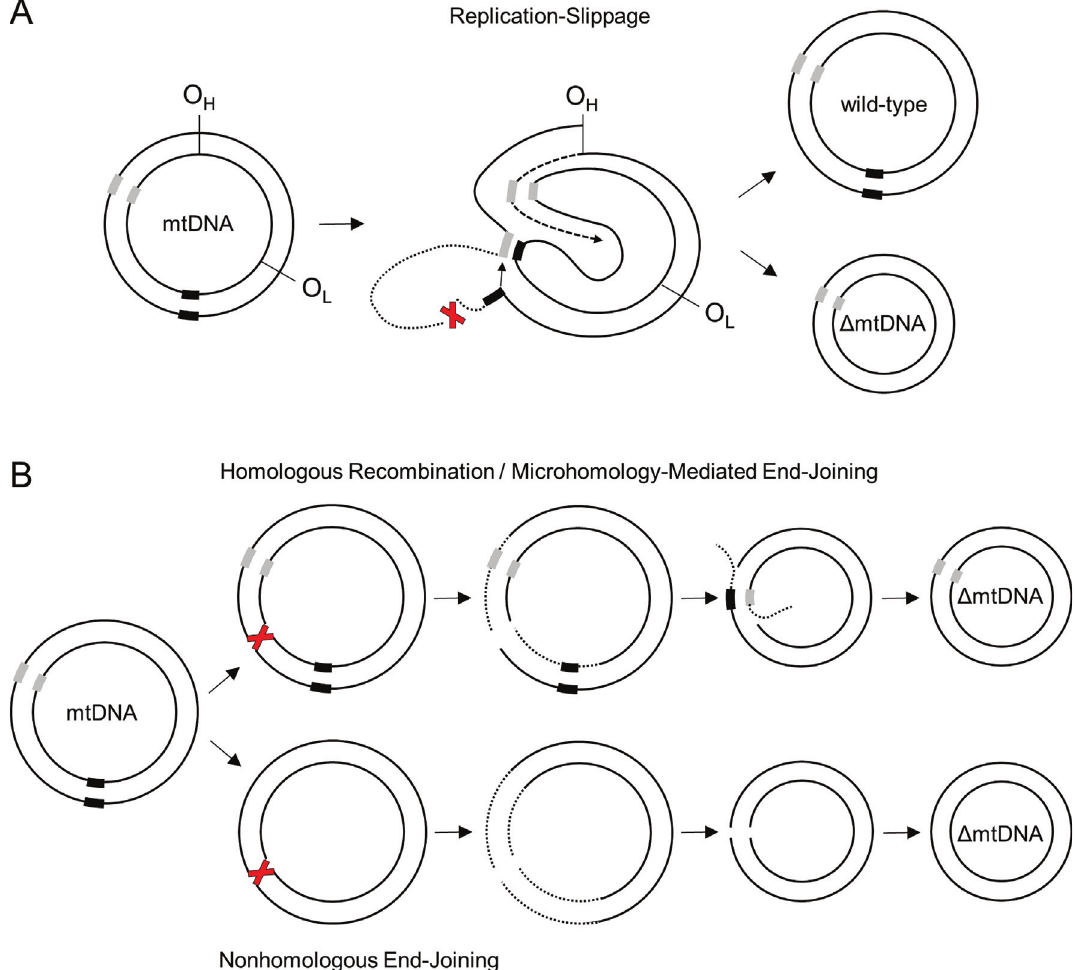
Figure 3 - Schematic representation of the debated mechanisms of mitochondrial DNA deletion formation. (A) In the replication-slippage (i.e. slipped mispairing) mechanism, a break of the displaced heavy DNA strand (indicated with a red X), generated during an asynchronous replication process, en- ablespairingofthe3’flankingregionofthatheavy-strand(greybox)withthe5’flankingregionofthelight-strand(blackbox),aheadoftheleadingDNA synthesis(dashedarrow).TheresultingunpairedDNAflap(dottedline)isthendegradedandligated(solidarrow)withtheremainderoftheheavy-strand. Replication initiated from O L would yield a daughter mtDNA molecule carrying the deletion of a segment ahead of the 3’ flanking region. The scheme representsthemodelproposedbyShoffner etal. (1989),anditwasmodifiedtoincorporatethelocationoftheheavy-strandbreaksaccordingtotheresults reported in Phillips et al. (2017). The position of the flanking regions corresponds to the 3’ and 5’ direct repeats (DRs) of the common deletion. (B) The formation of deletions in the homologous recombination- or microhomology-mediated end-joining-based mechanism (upper panel) is initiated by a dou - ble strand break (indicated with a red X), which occurs predominantly within the region between the two replication origins. Excision of both heavy and light-strands in 3’-5’ direction (dotted lines) enables pairing of the unveiled complementary flanking regions (grey and black boxes). Next, flap excision and subsequent ligation would generate a daughter mtDNA molecule carrying the deletion and retaining one flanking region. The scheme represents the model proposed by Krishnan et al. (2008). Class III mtDNA deletions have been suggested to form via nonhomologous end-joining of linear molecules (lower panel), which to date remain uncharacterized. The scheme has been modified from Chen et al.